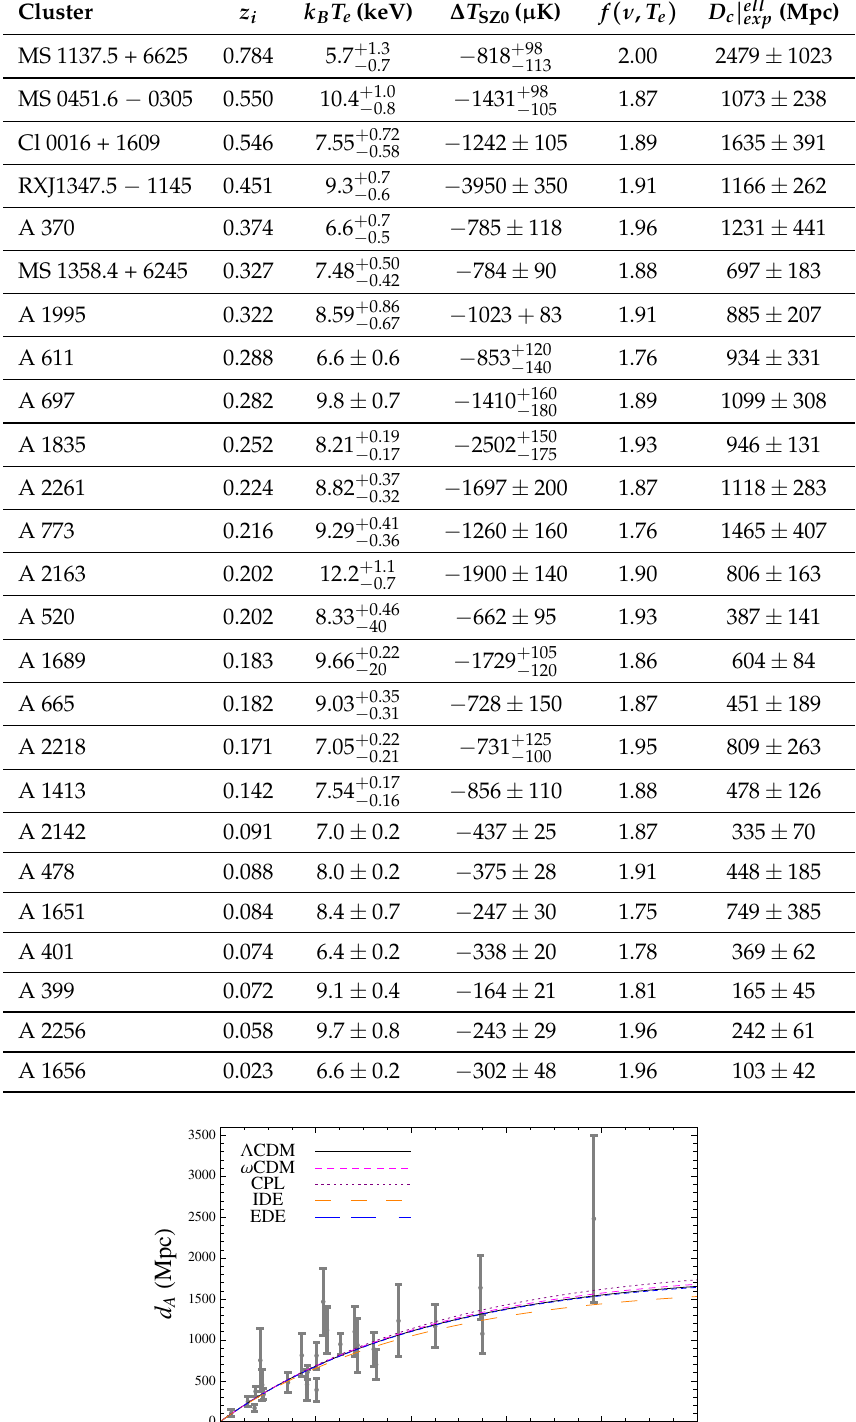
Table A1. Galaxy Cluster data set from De Filippis et al. for 25 data points (SZ/X-ray). See [1] for complementary observational information.